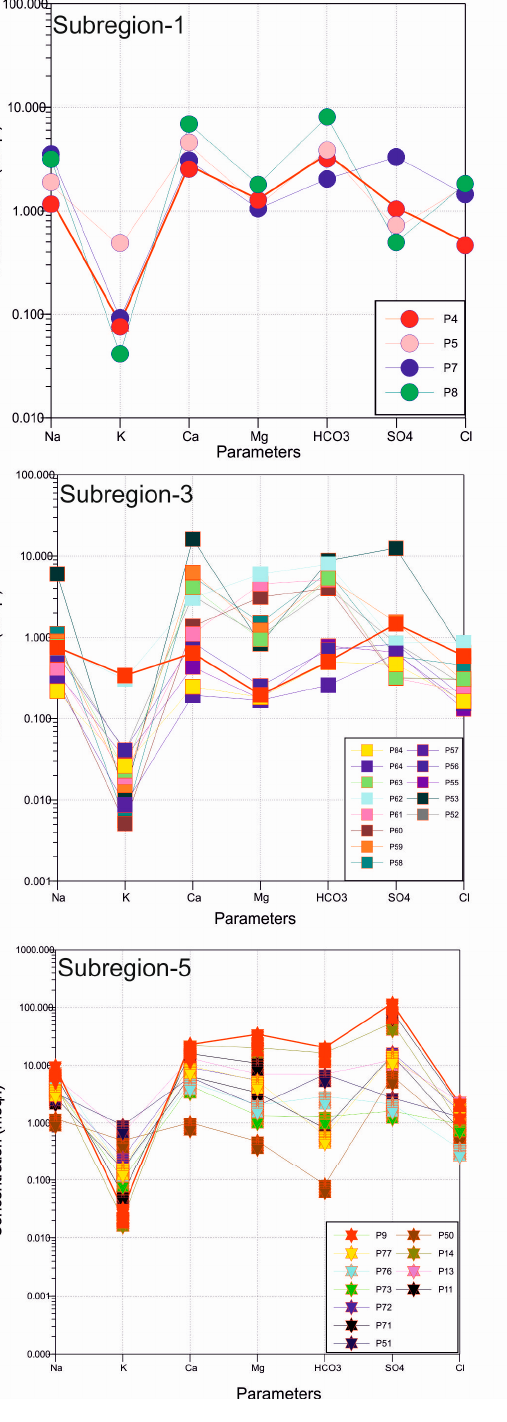
Figure 7. Schoeller diagram of the average concentrations of anions and cations.